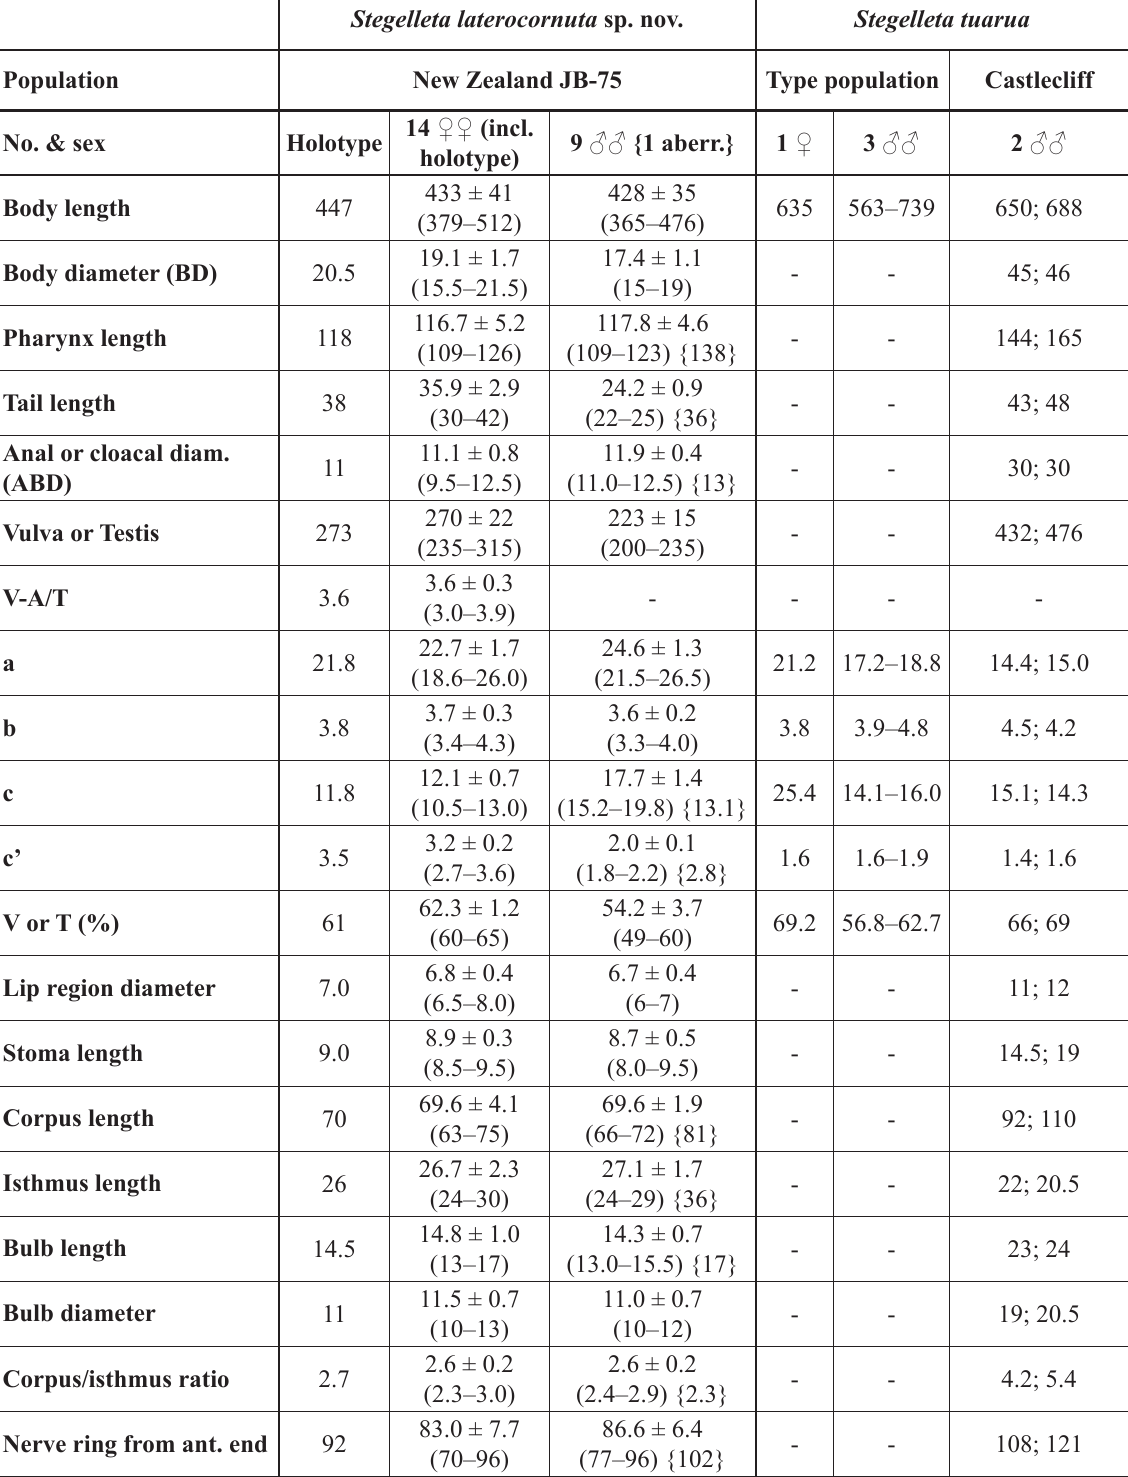
Table 2. Measurements (in µm) of Stegelleta laterocornuta sp. nov. and S. tuarua Yeates, 1967 from Castlecliff, New Zealand, the latter compared to the type population (presented as mean ± s.d. and (range) or only range).* Number of annuli from anterior end to nerve ring, excretory pore and deirid, respectively; - indicates that data is not available or not